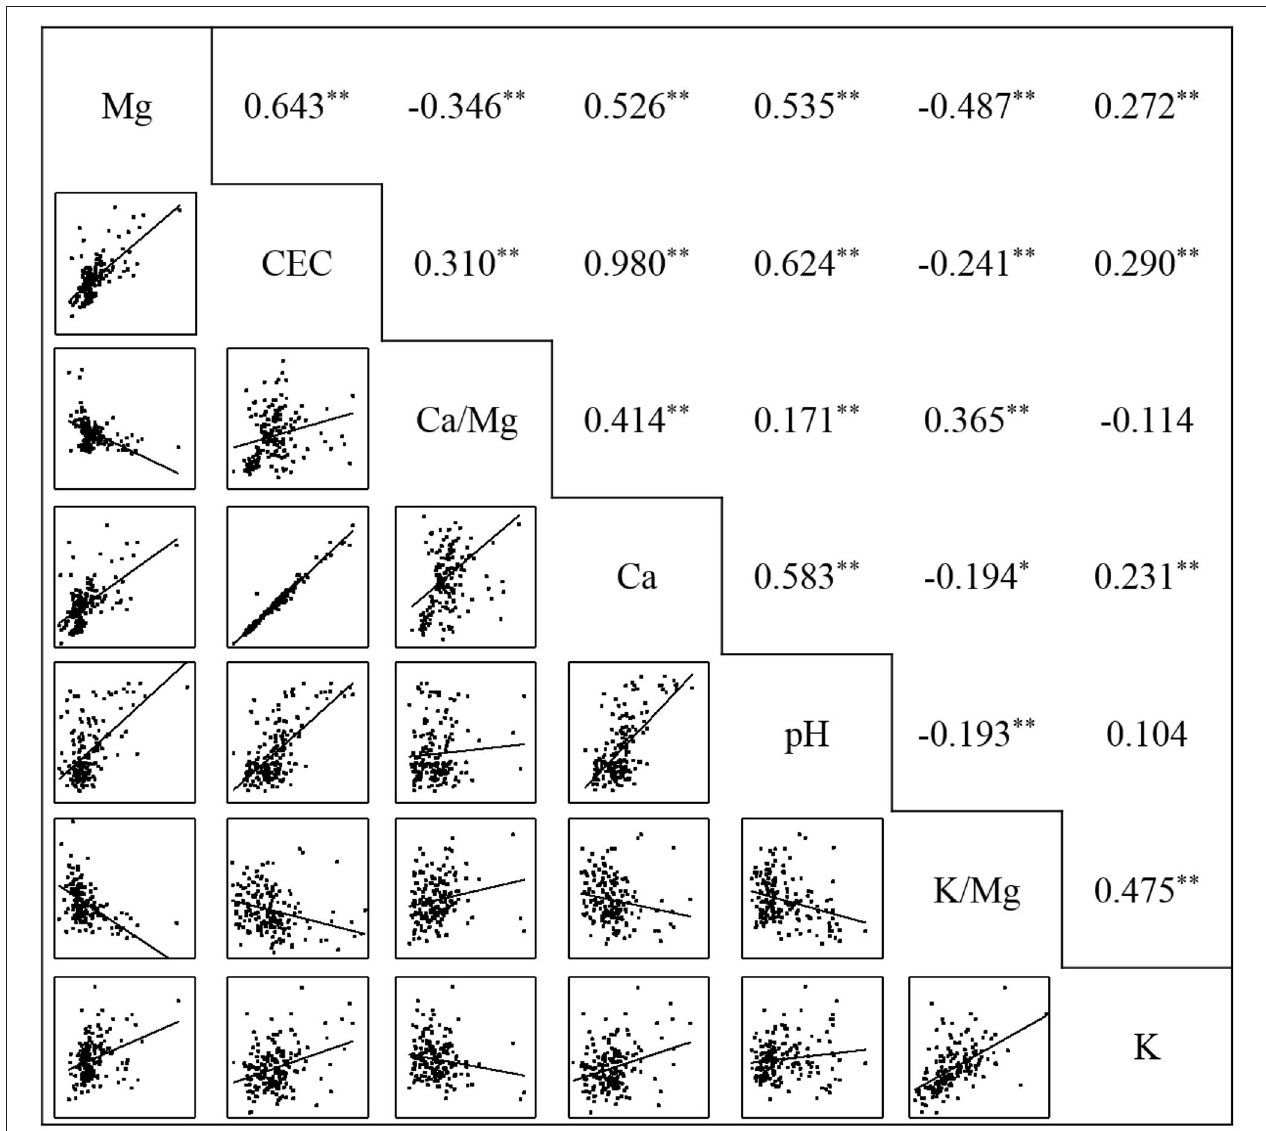
FIGURE 5 | Correlation matrix among soil ex-Mg, pH, and soil properties. The values of the 0–20cm soil layer were used ( n = 179). * and ** indicate that the corresponding values are significant at P < 0.05 and P < 0.01,